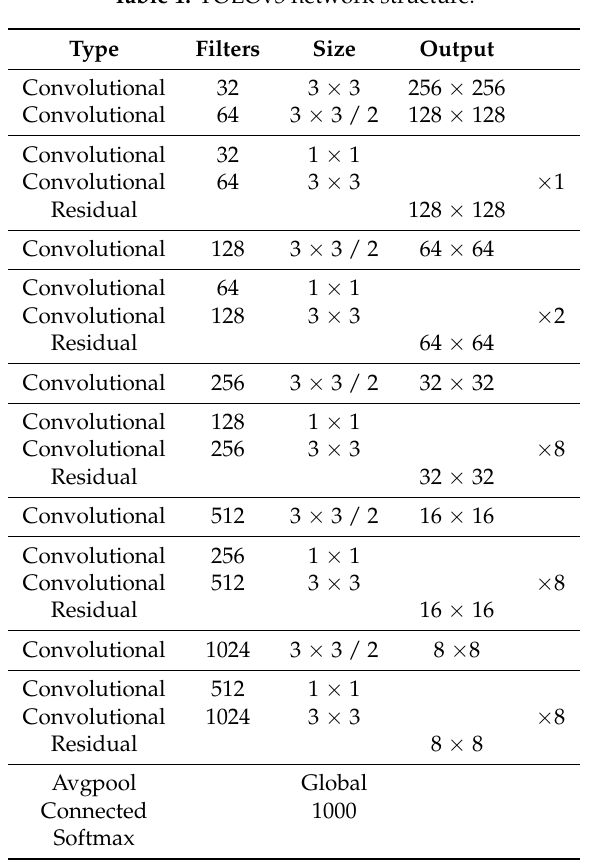
Table 1. YOLOv3 network